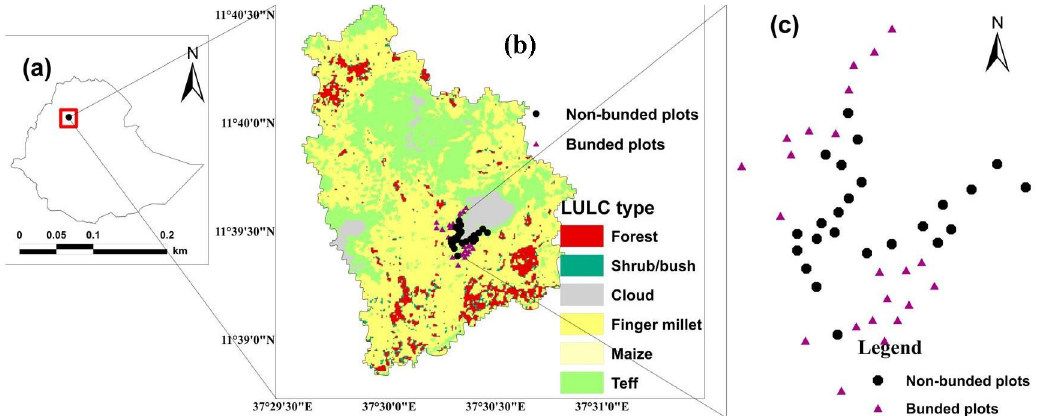
Fig 1. Locations of study catchment and soil sampling plots: (a) Ethiopia, (b) Aba Gerima land-use/land-cover (LULC) types, and (c) Soil sampling plots.